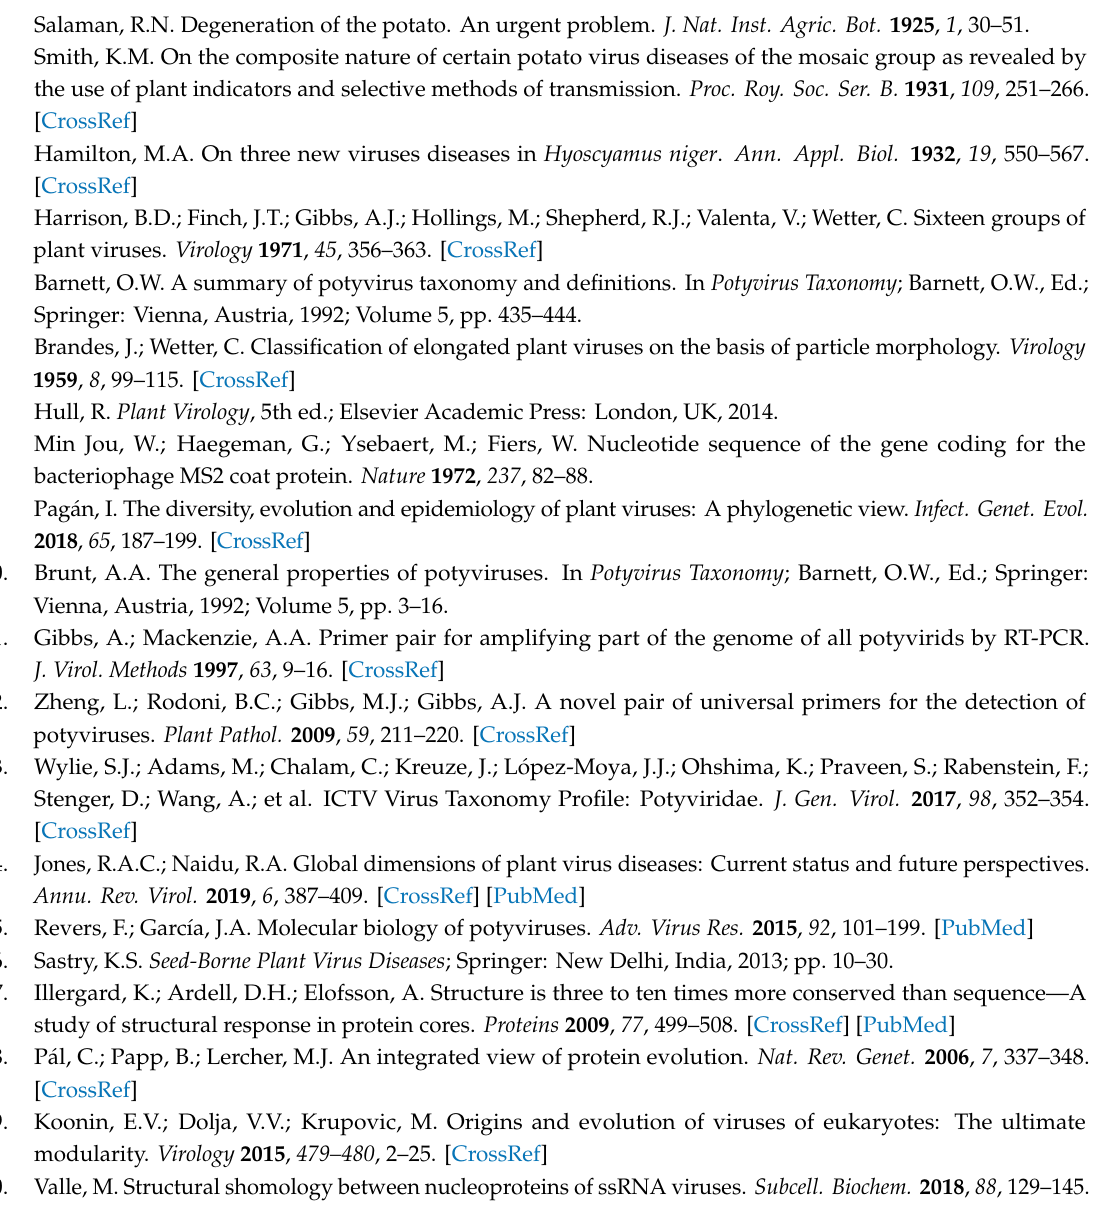
Figure S1. A ML phylogeny of 38 representative potyviruses making subtree comparisons of node